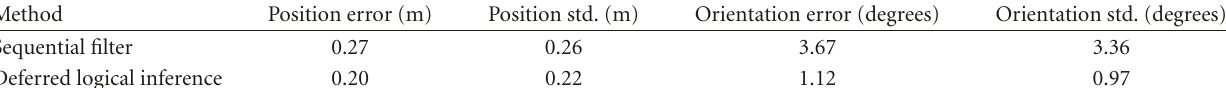
Table 1: Position error (the true position is given by a RTK GPS) for the proposed deferred logical inference method and a sequential particle filter.